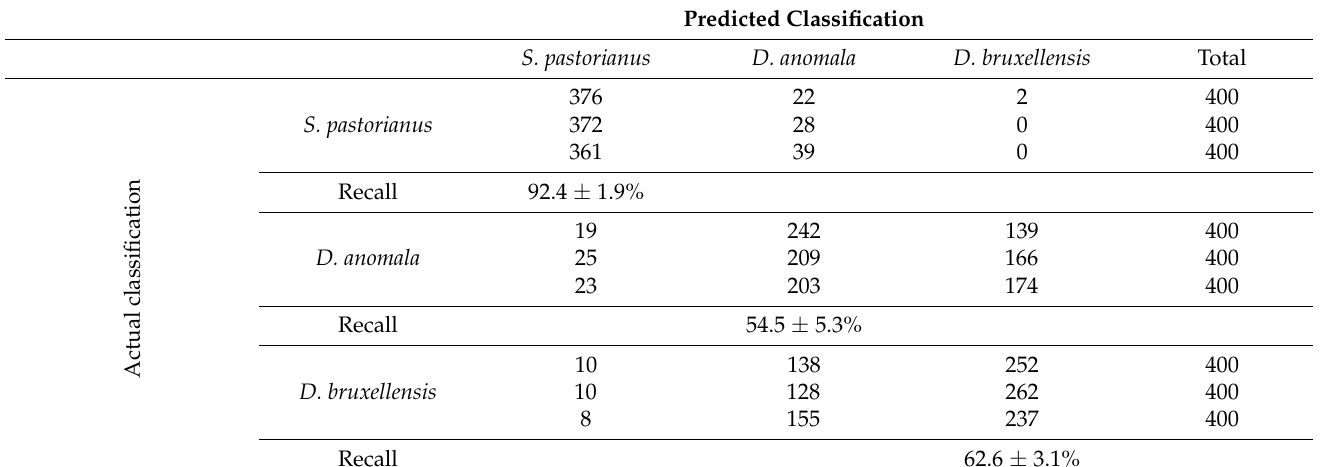
results indicate the potential of I p – t d analysis by RPM for the quantitative detection of S. pastorianus in solution and the accurate detection of Dekkera spp. contamination. Table 1. Discrimination of investigated yeasts based on log 10 I p acquired by